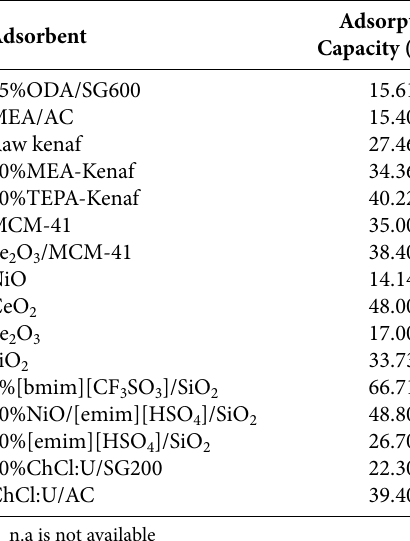
Table 1. Adsorption capacities of various